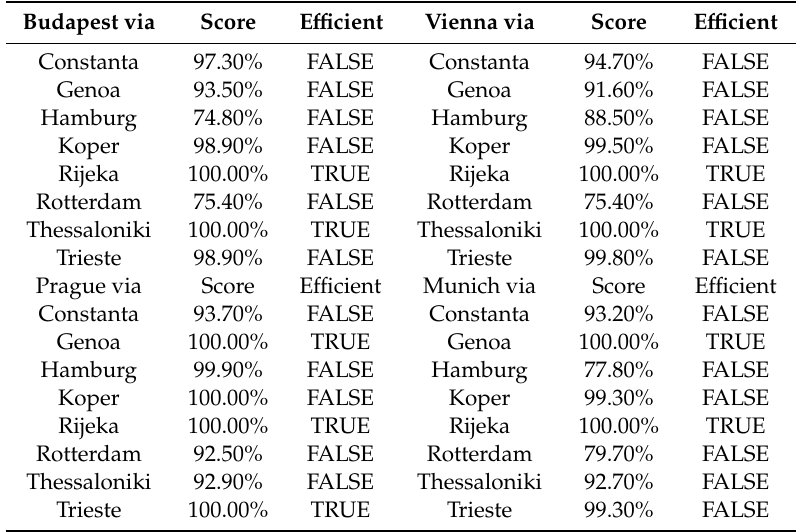
Table 3. Transport route rankings among the alternatives from Shenzhen to Central European destination, according to DEA.